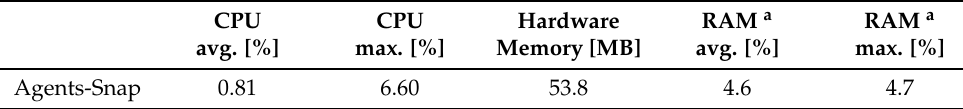
Table 3. Resource demand of the agents-snap measured on the physical control unit.